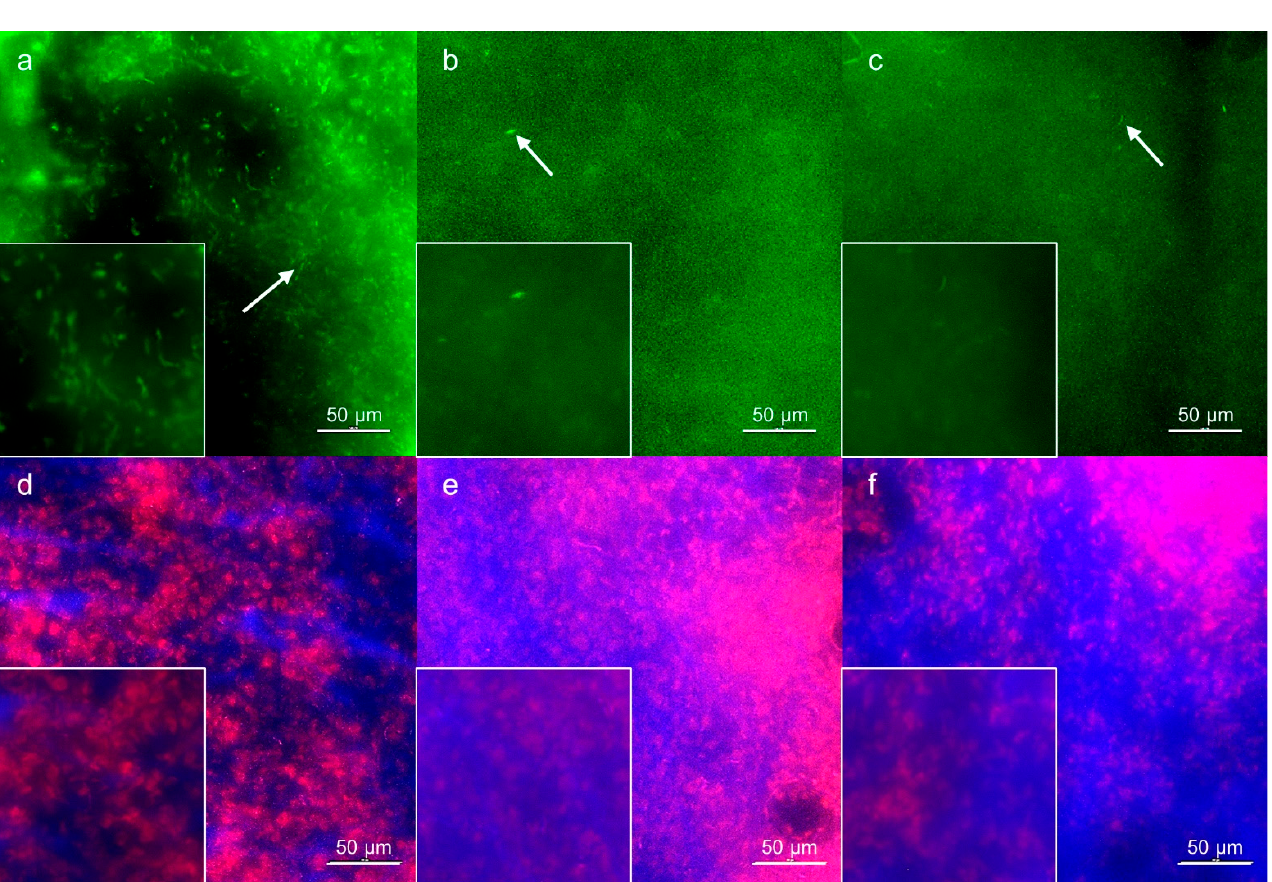
Figure 3. Representative fluorescence microscopy images showing the impact of PUFA administration on ROS/RNS in wound tissue samples. ( a – c ): CellROX™ Green Reagent staining; ( a ) control group, ( b ) group A, ( c ) group B. Green fluorescence is proportional to the amount of ROS accumulated in the tissue sample. Note the fluorescence of the nuclei (white arrows) in control group ( a ), group A ( b ), and B ( c ). ( d , e ): 2,3-diaminonaphthalene staining; ( d ) control group, ( e ) group A, ( f ) group B. The intensity of blue fluorescence corresponds to the amount of RNS in the tissue sample. The nuclei are counterstained with propidium iodide (red fluorescence). Note that in group B ( f ) the intensity of blue fluorescence overlays fluorescence of the stained nuclei. The insets represent magnified details. The bars represent 50 μ m.